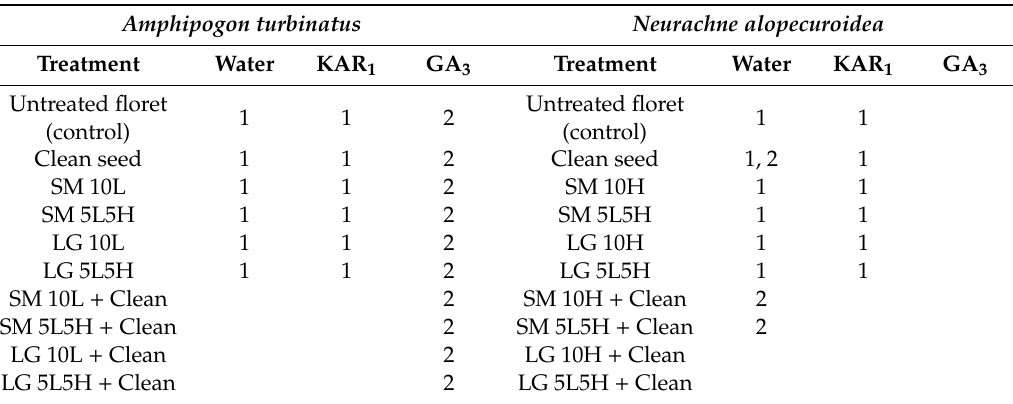
Table 3. A list of all treatments tested for each species and the growth mediums which these were tested on. The treatments tested for each species are marked as “1” (tested in round one) and / or “2” (tested in round two). Water, KAR 1 , and GA 3 indicate whether the treatment was tested on water-agar, KAR 1 -agar, or GA 3